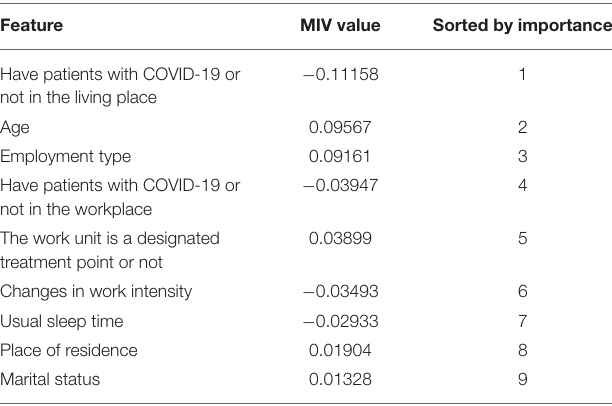
TABLE 6 | Feature variables that affect mental health: sorted by importance. Feature MIV value Sorted by